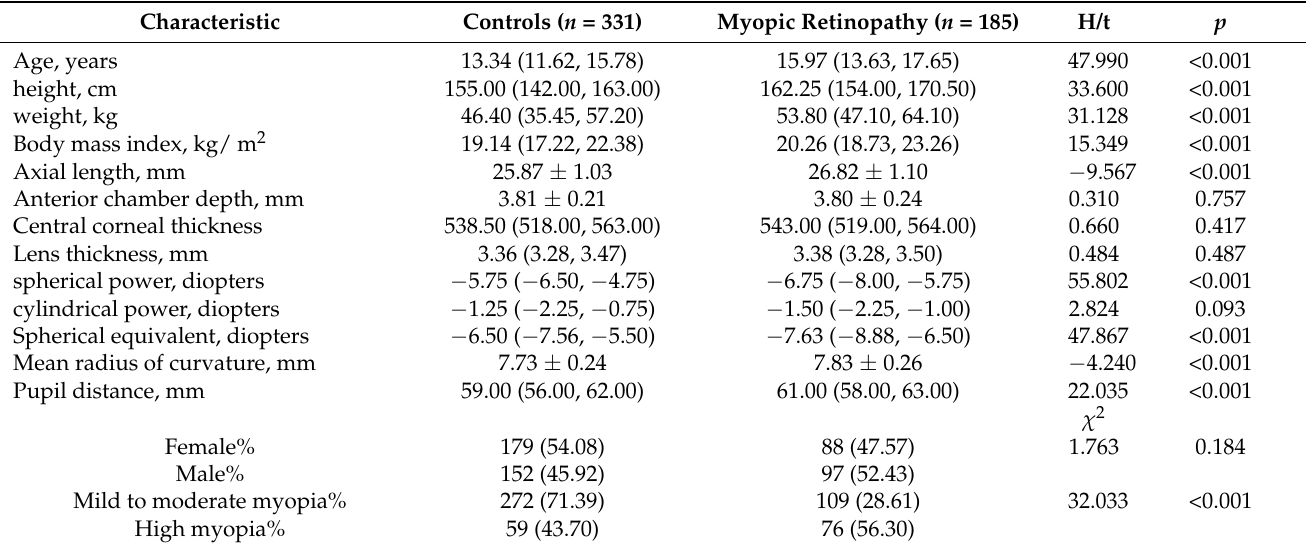
Table 2. Comparison of Systemic and ophthalmological parameters of Subjects with and without macular